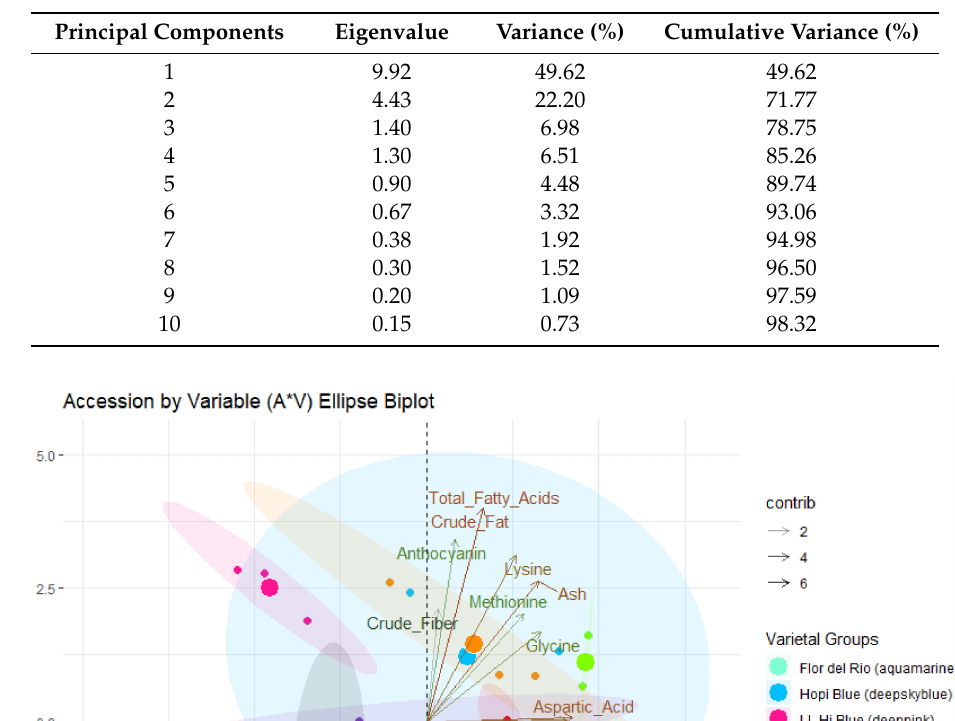
Table 6. Eigenvalue, variance contribution (%), and total cumulative variance (%) of principal components.